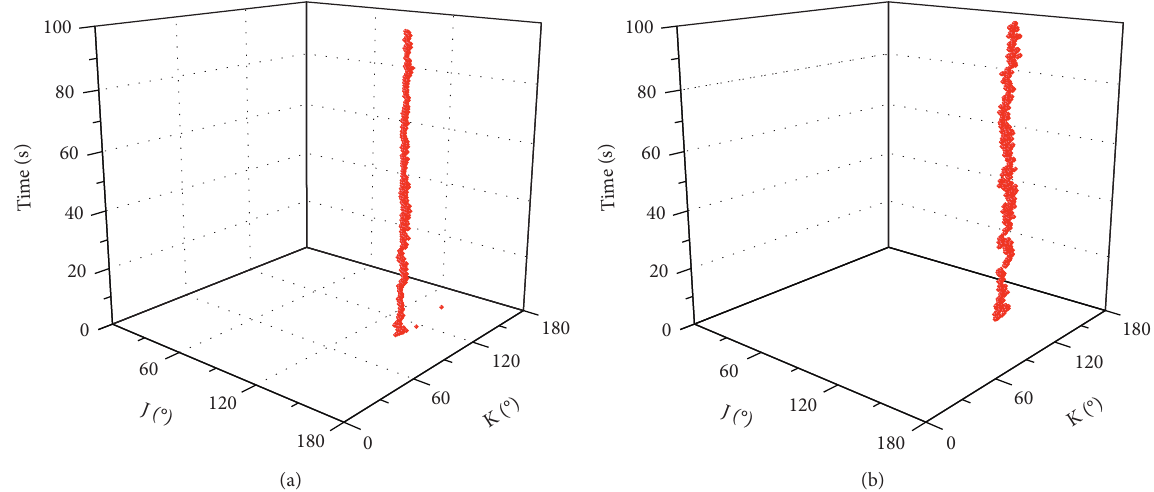
Figure 12: Time-varying angle of maximum shear stress at the fatigue critical point. (a) “Wind-induced” case. (b) “Welding-wind-induced” case.